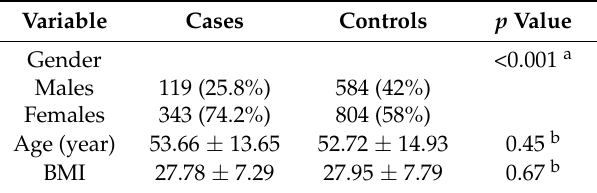
Table 1. Differences between cases and controls in sociodemographic